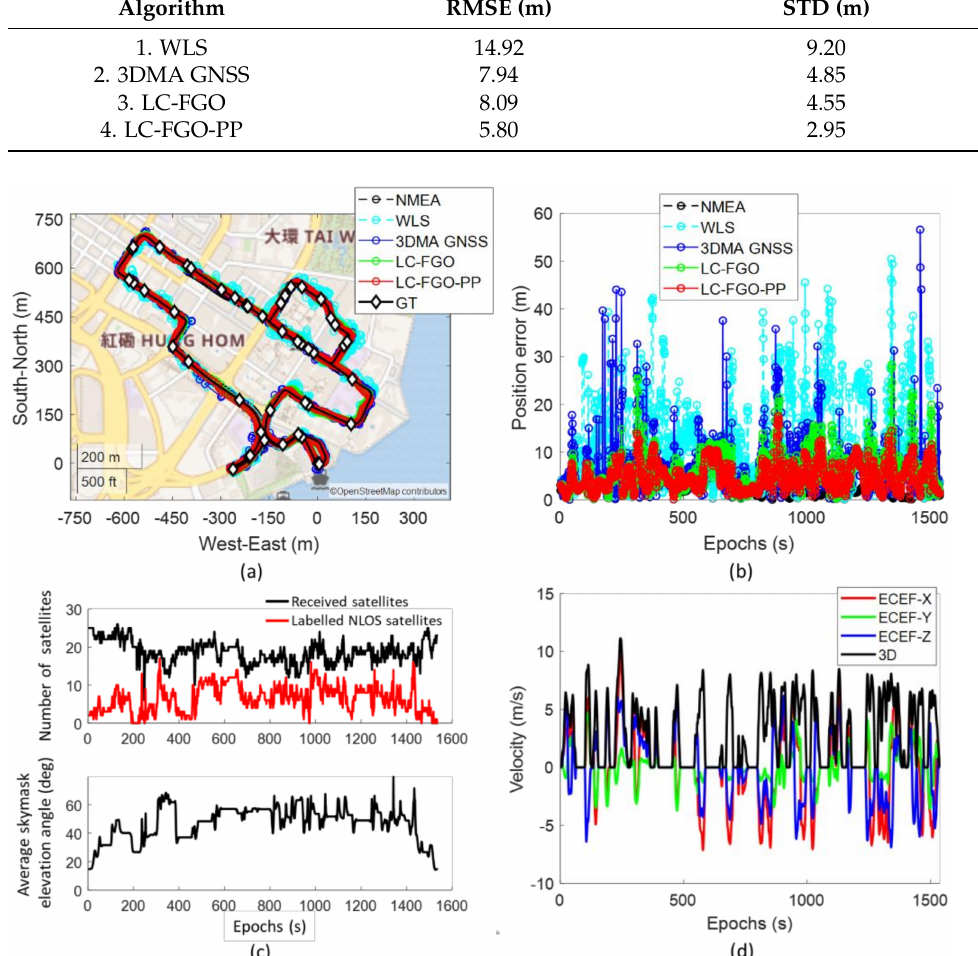
Figure 9. ( a ) map plot, ( b ) positioning errors, ( c ) number of received satellites and average sky- mask elevation angle, and ( d ) velocities under the ECEF coordinate system provided by NovAtel SPAN − CPT of the vehicle-mounted